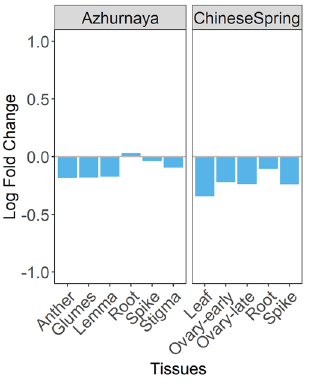
Fig. 6 Ratio of triads signi fi cantly biased towards AB and D subgenomes in cultivar Azhurnaya and landrace Chinese Spring. The ratios are represented as log fold change (LogFC) values depicted by the blue bars. A LogFC < 0 indicates more triads are biased towards the AB subgenome than the D subgenome and a LogFC > 0 indicates more triads are biased towards the D subgenome than the AB